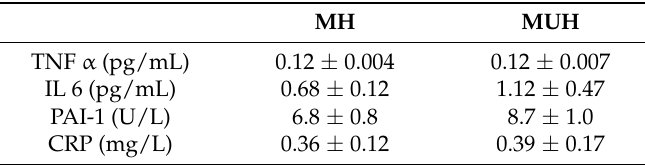
Table 2. Proinflammatory Markers and CRP of healthy children and children suffering from metabolic